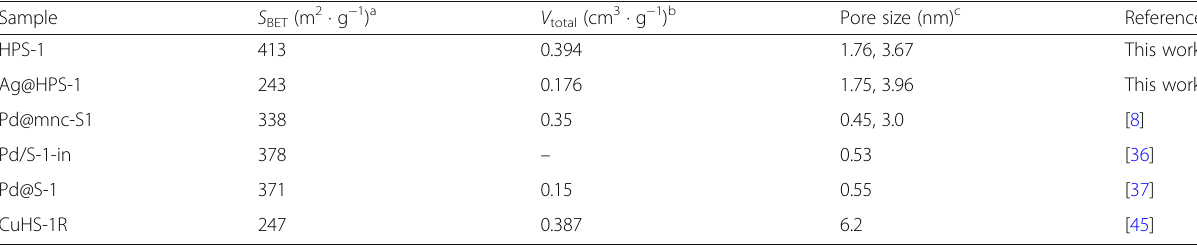
Table 1 The results of N 2 adsorption-desorption for different zeolite-based samples